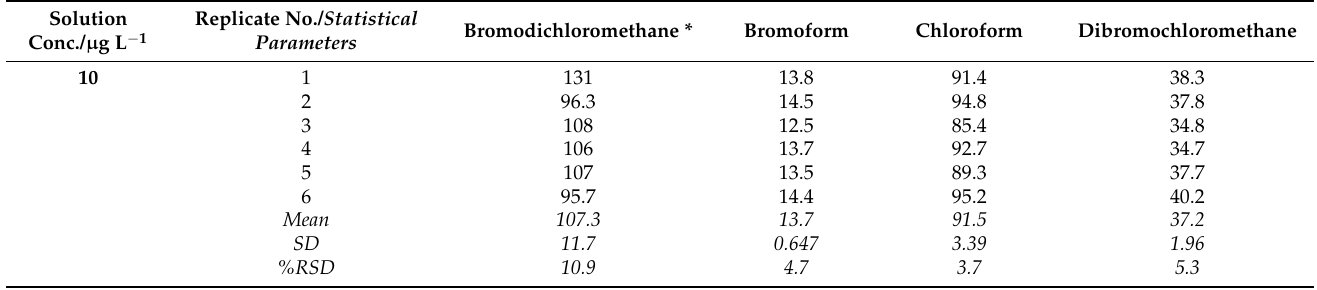
Table 7. Precision data for the THMs (mean across quantitation ions) at solution concentrations of 10, 50, and 90 µ g L − 1 . Reported data, mean, and standard deviation (SD) are shown in ppbV (headspace), while RSD is shown as a